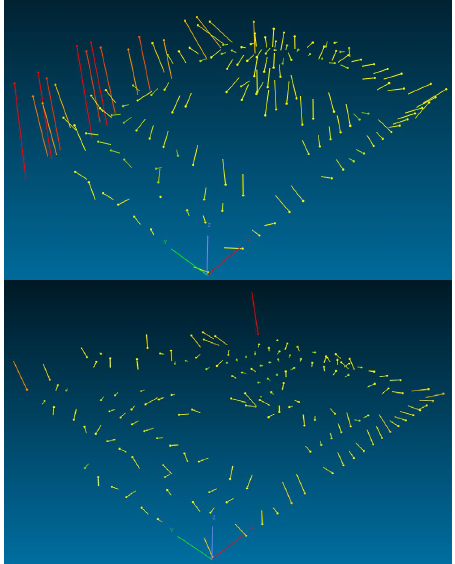
Figure 10. 3D error vectors (exaggerated by factor 75) of the 3D points calculated from the closer image pair for implicit form (top) and explicit form